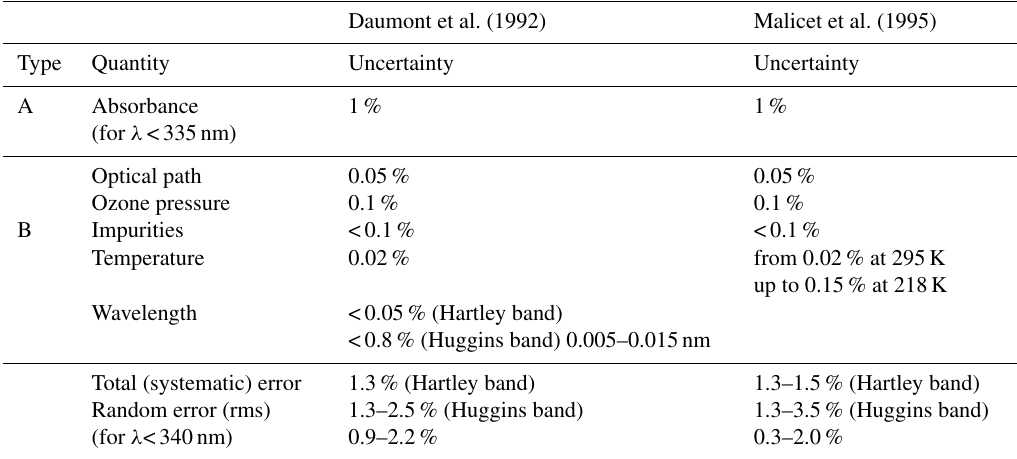
Table 3. Summary of uncertainties as reported by Daumont et al. (1992) and Malicet et al. (1995).